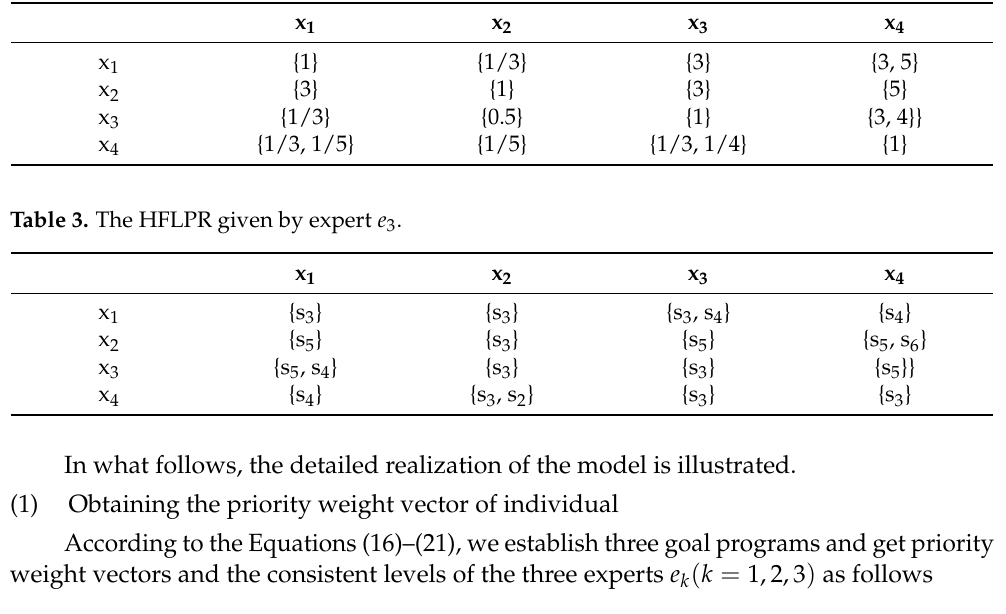
Table 2. The HMPR given by expert e 2 .